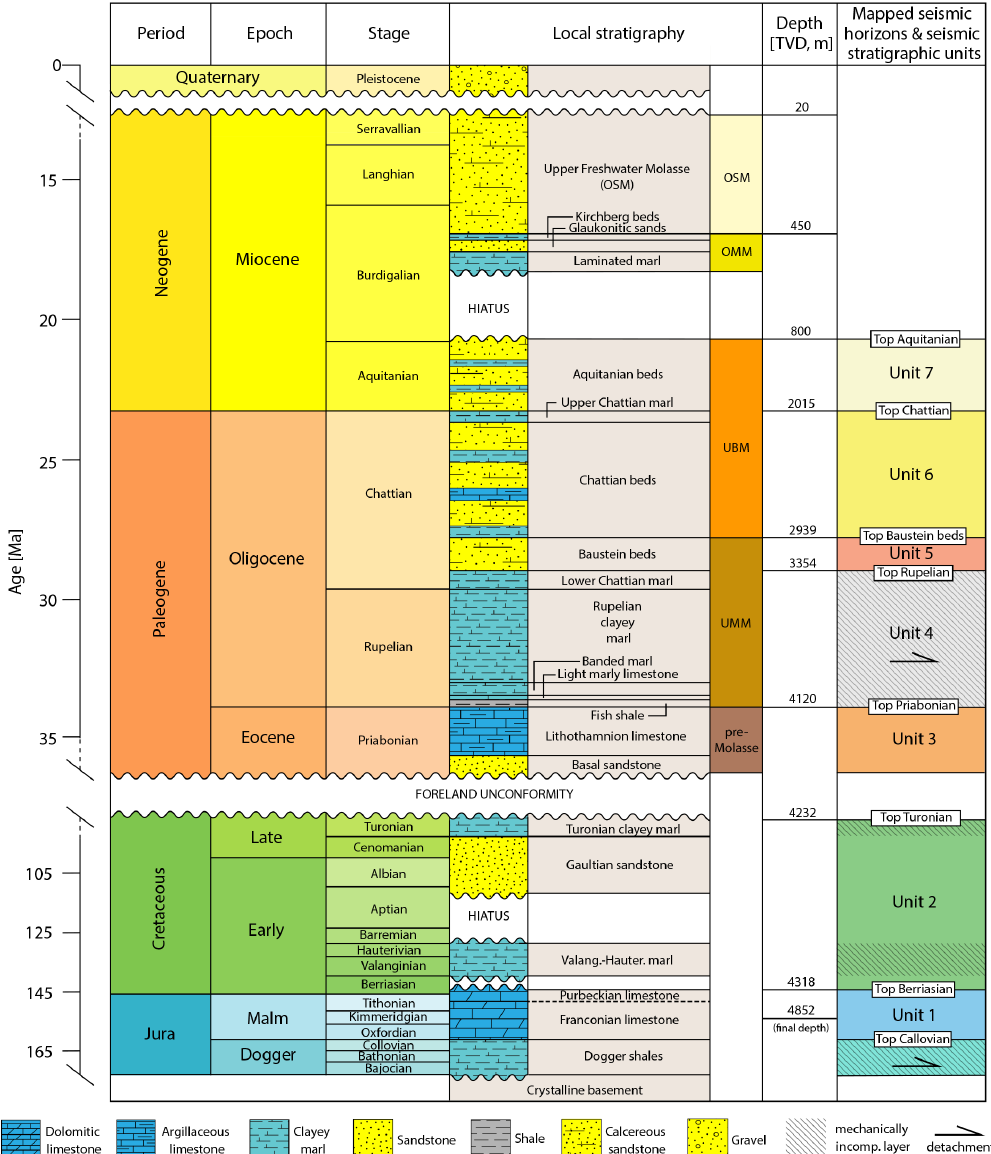
Figure 2. Detailed stratigraphy of the study area. Formation tops in depth were taken from the GEN-1 well. Qualitative mechanical stratigra- phy (Fischer, 1960; Müller, 1970; Budach et al., 2017) and the location of inferred detachments (Bachmann et al., 1982; Müller et al., 1988; Ortner et al., 2015; von Hartmann et al., 2016) are also indicated. Mapped seismic horizons, and the stratal units they bound, are depicted in the right column. For stratigraphic abbreviations, see Fig.